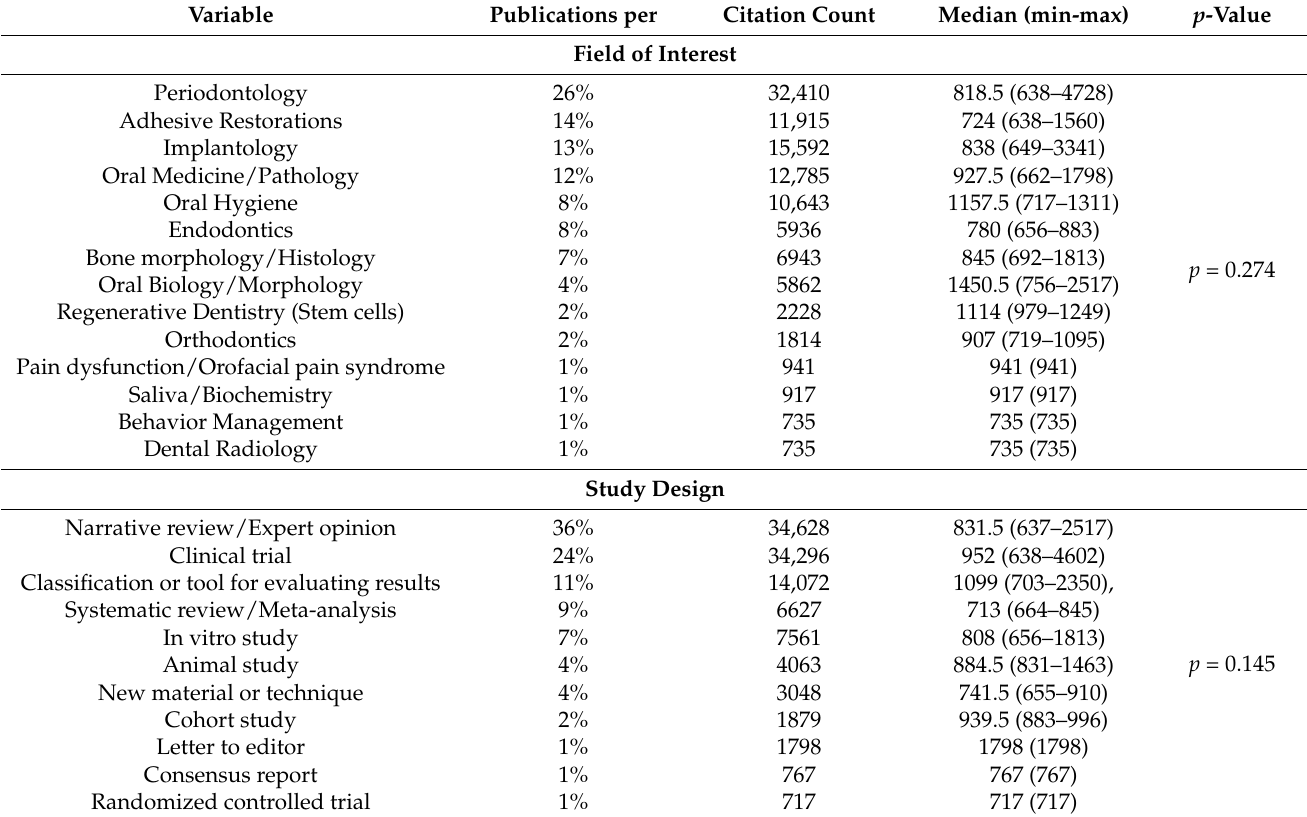
Table 3. Distribution of fields of interest, study designs, and evidence levels of the top 100 most-cited articles.